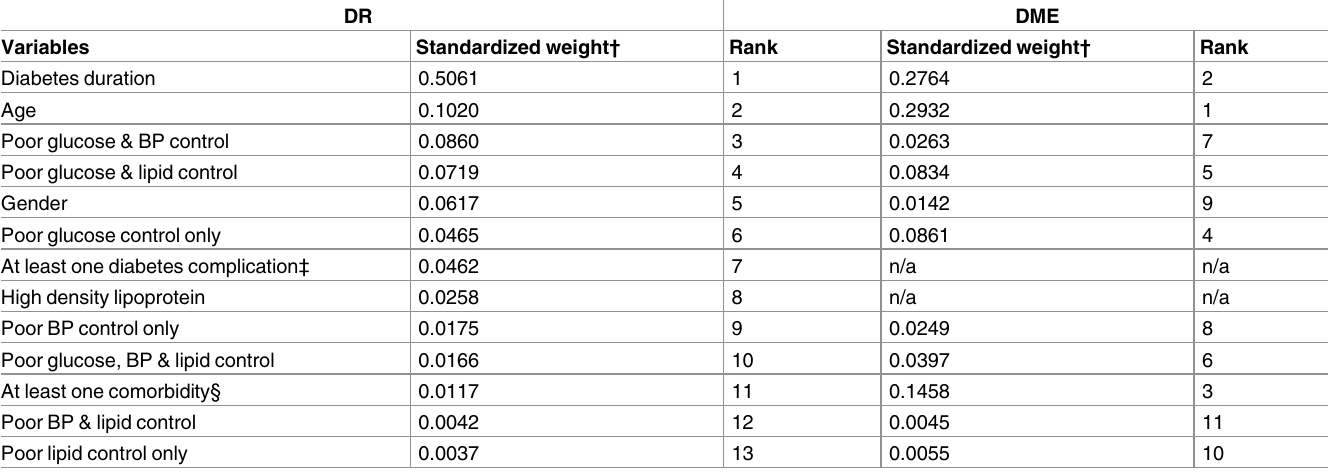
Table 3. Importance of associated factors for DR and DME *